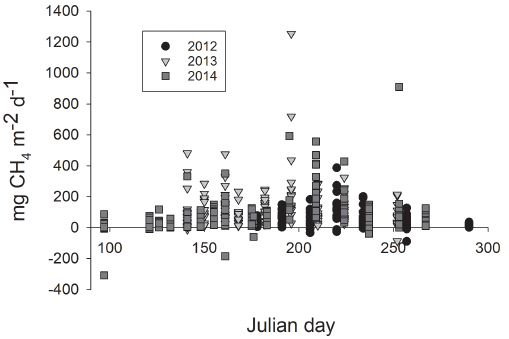
Figure 3. The measured methane fluxes in three subsequent years.